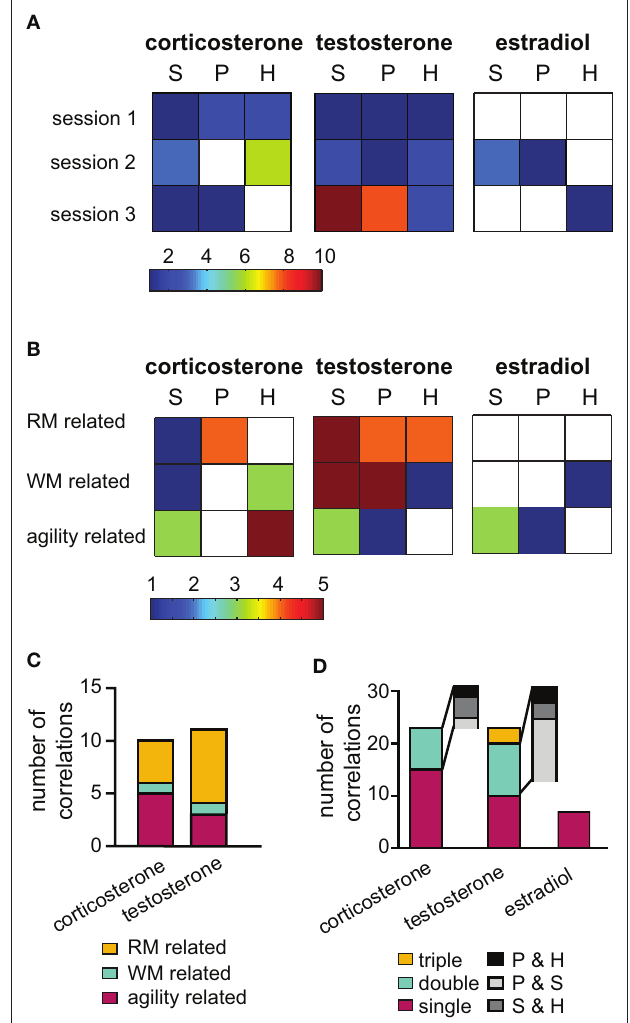
Figure 3 | Correlation analysis of hormones and behavioral data. To illustrate the relevancy of hormones over the training course, in (A) the number of significant correlations per session (acute groups G1, G2, and G3 only) are depicted color coded for each tissue type (S = serum, P = PFC and H = hippocampus). Testosterone expressed the highest number of significant correlations in the last session. In (B) the same data was arranged with parameters classified into three behavioral categories: working memory (WM), reference memory (RM) or unspecific activity (agility) related. (C) Outcome of the multiple regression analysis grouped according to the behavioral classification. (D) Illustrates the number of correlations occurring between a behavioral parameter and tissue types: if the parameter correlated significantly with one tissue only, it is termed “single,” “double” for two tissues and triple if correlation occurred between the parameter and all three samples. The gray insets illustrate the tissue pairs present in the double correlation